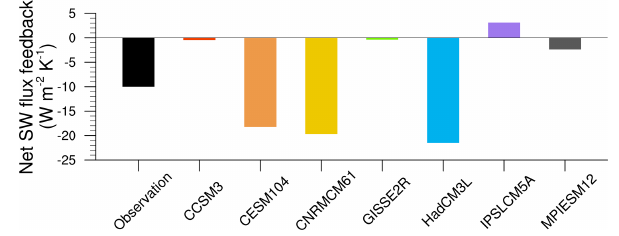
Figure 3. Net shortwave heat flux feedback in the observations and the